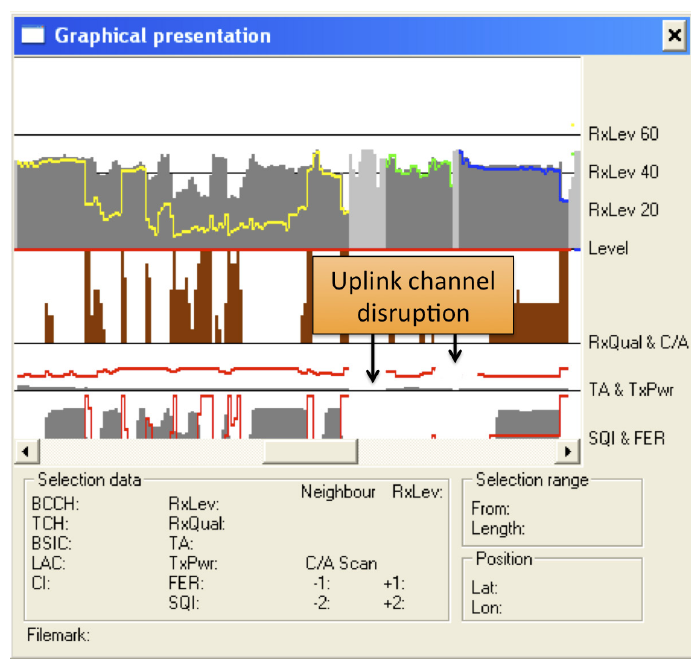
Figure 11. Uplink loss and cell reselection.